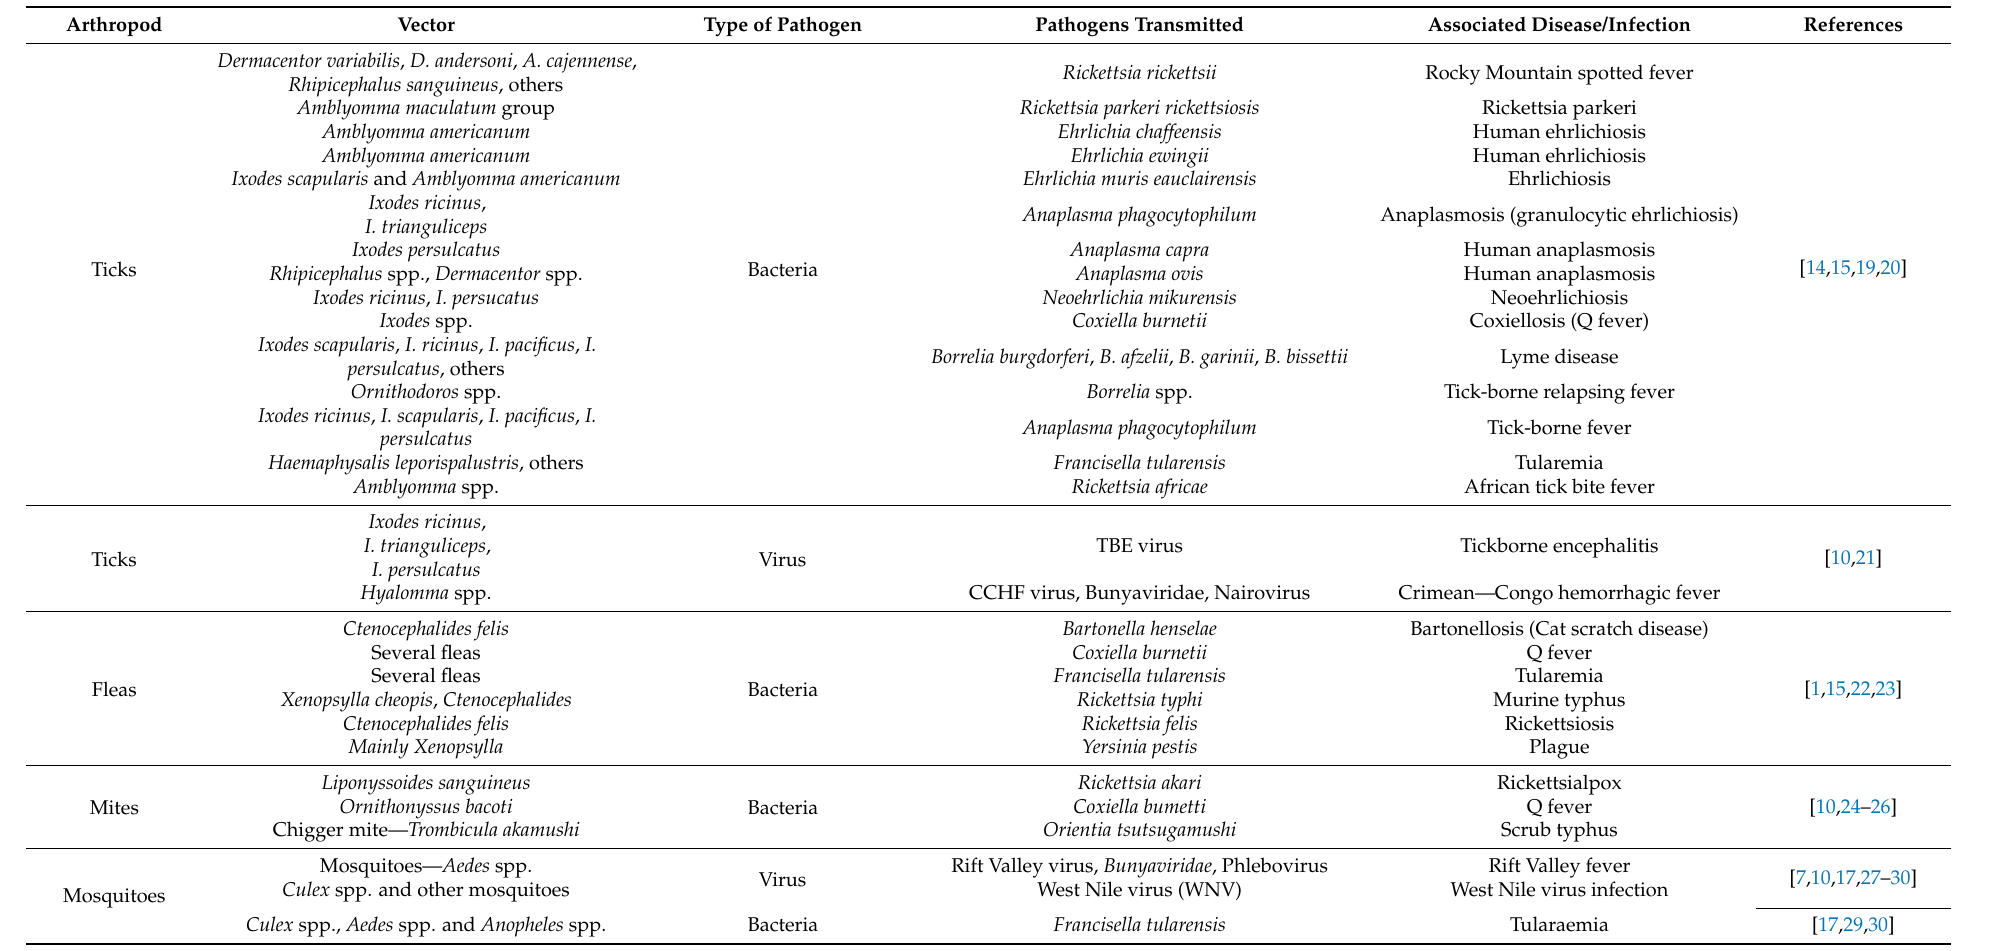
Table 1. Viruses and bacteria-associated diseases or infections caused by